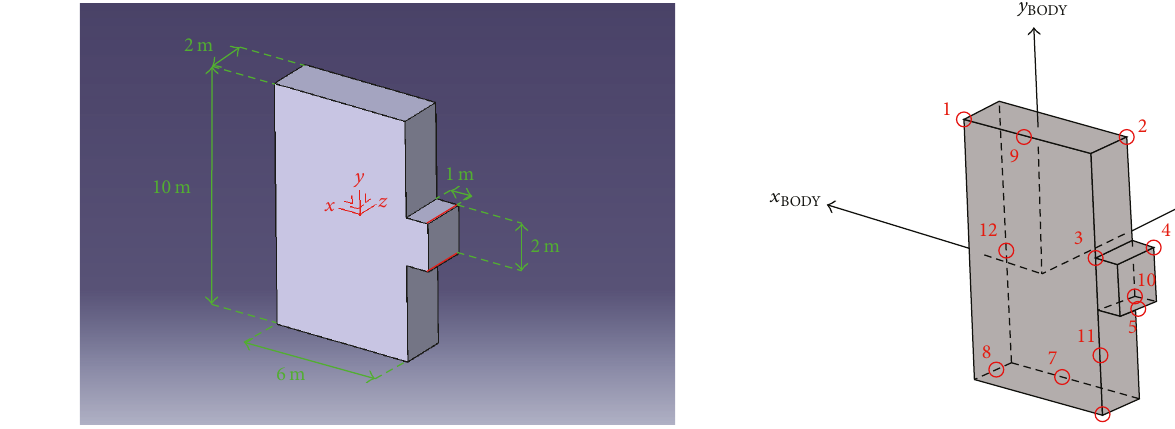
Figure 4: CATIA 3D Model of the target. The dimensions of the body, expressed in meters, are given in green, while the Body Dummy Reference Frame is shown in red.